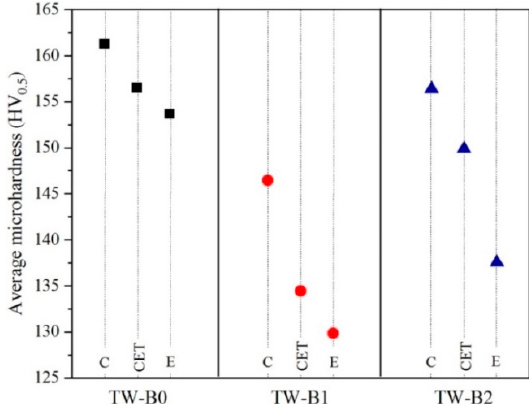
Figure 11. Average microhardness profile of studied TWIP steels in the as-cast condition.